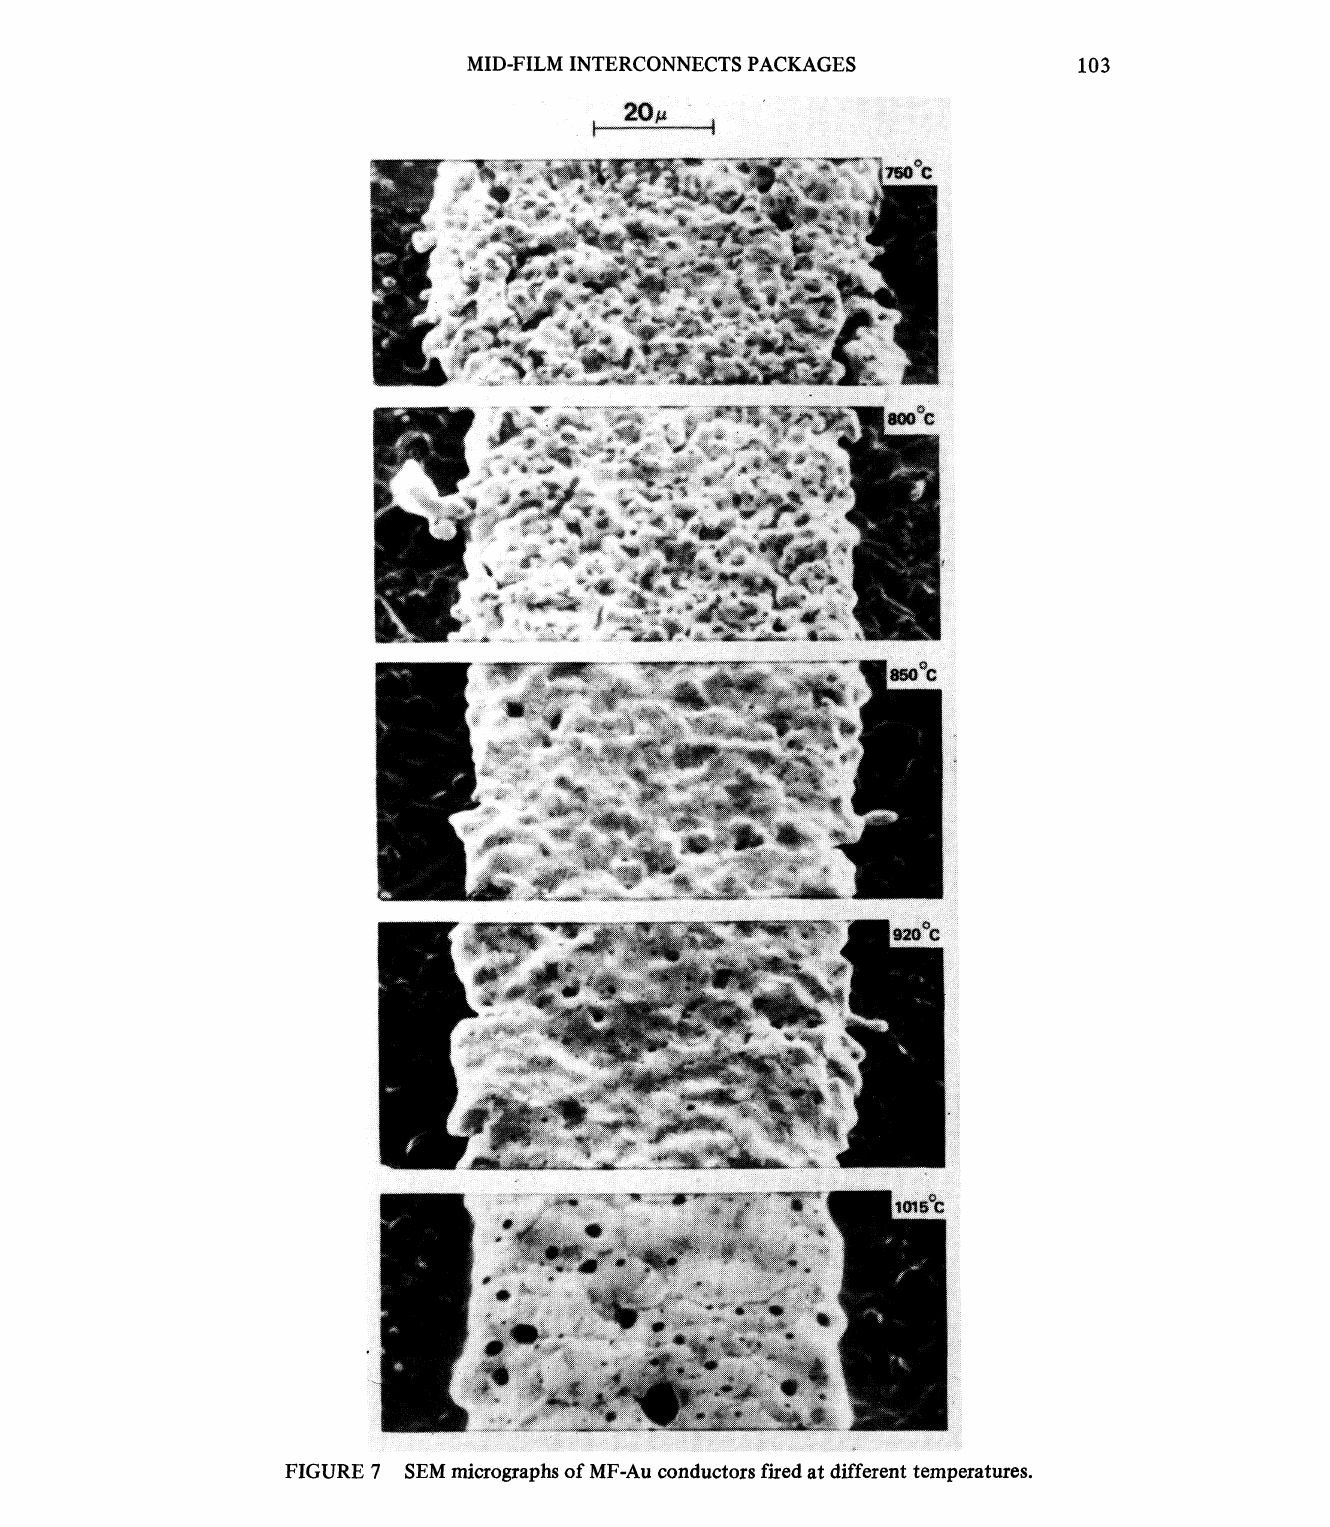
FIGURE 7 SEM micrographs of MF-Au conductors fired at different